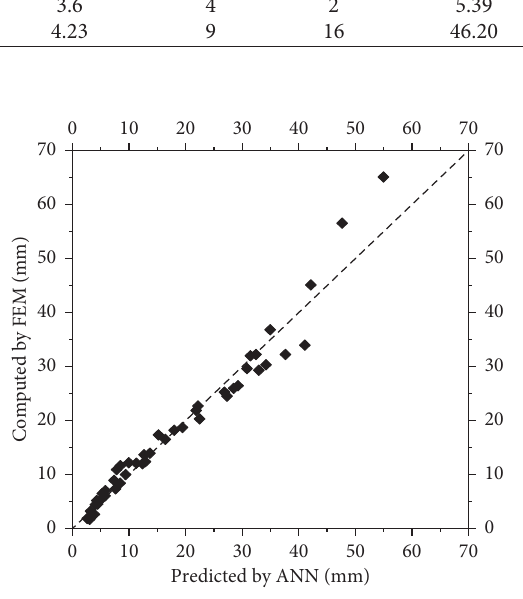
Figure 4: Comparison between maximum retaining wall deflec- tions computed by finite element simulations and predicted by the ANN